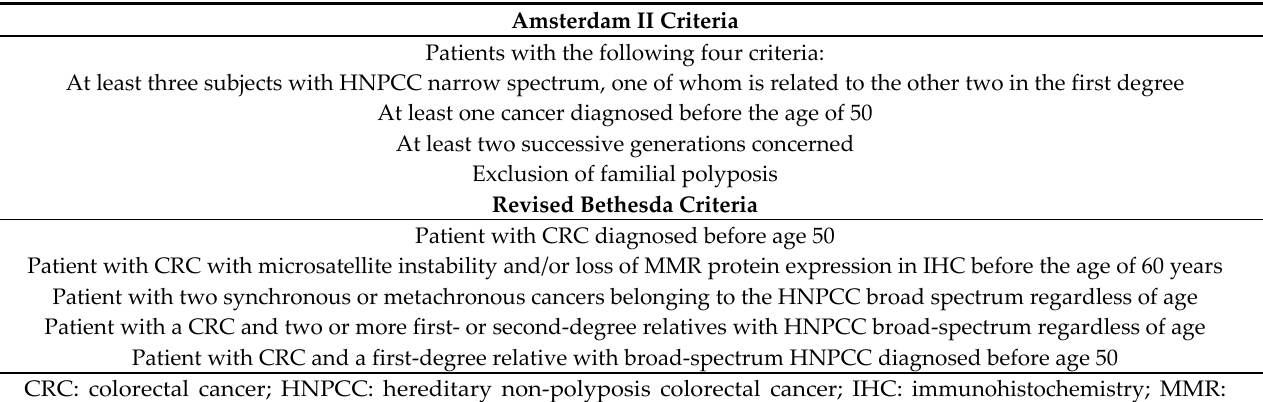
Table 1. Amsterdam II and Bethesda revised